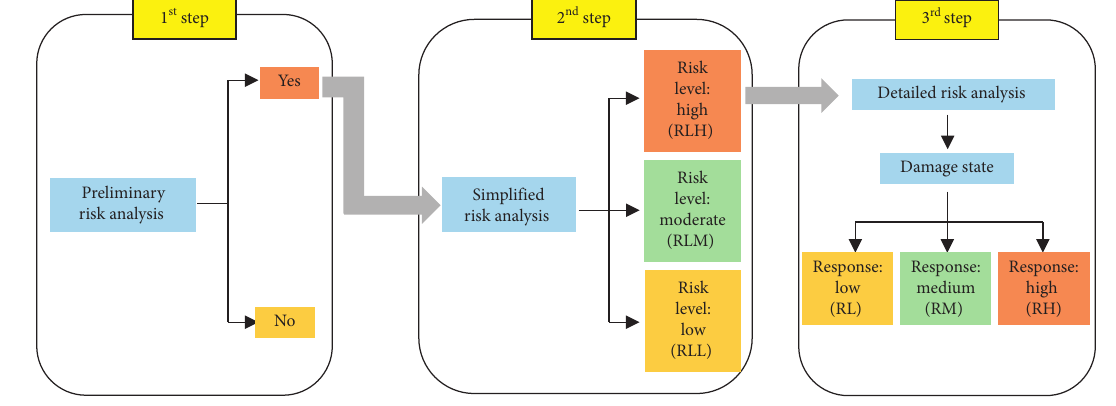
Figure 2: Risk-based methodology procedure of this study. Table 1: Various methods for determining grade interval [3]. Technical data classification